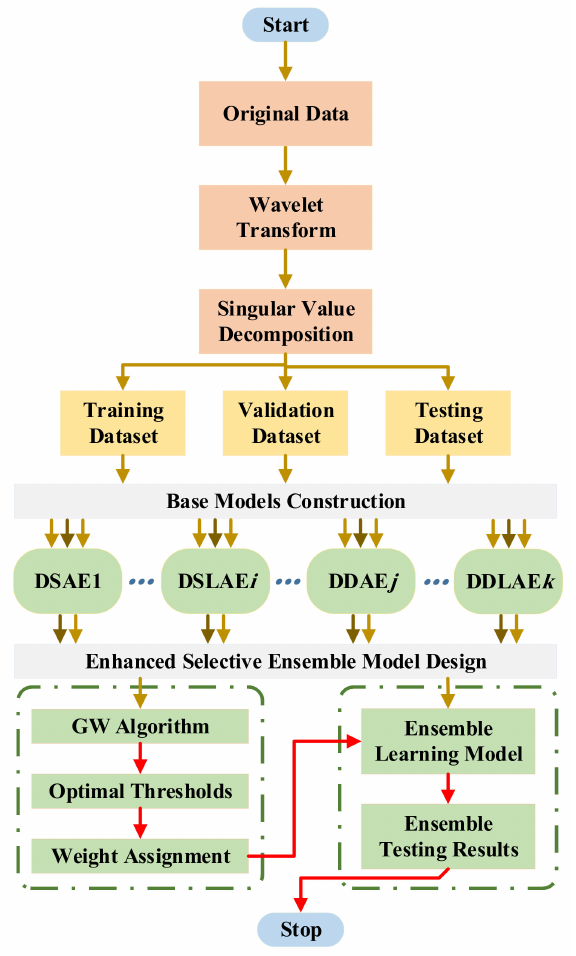
Figure 2. Diagram of the offered FDIA detection